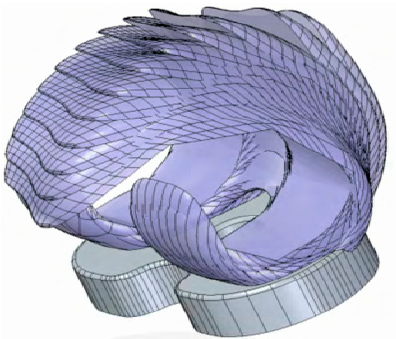
Figure 1. The prosthesis geometry in SolidWorks [12].